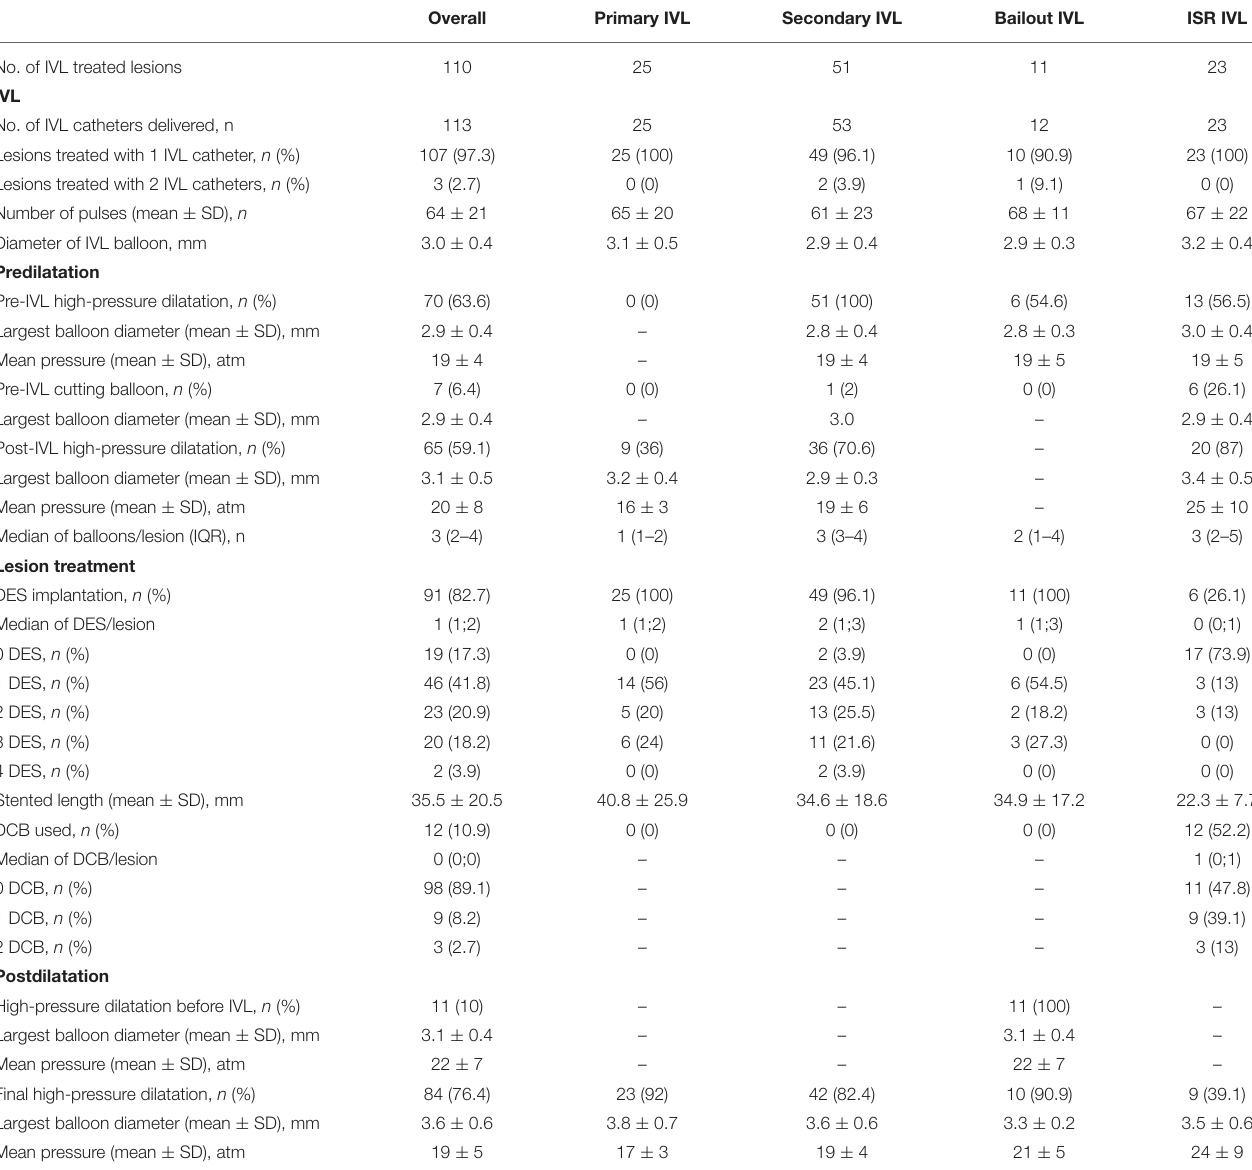
TABLE 3 | Procedural characteristics of lesion treatment in the overall population and patient subgroups.